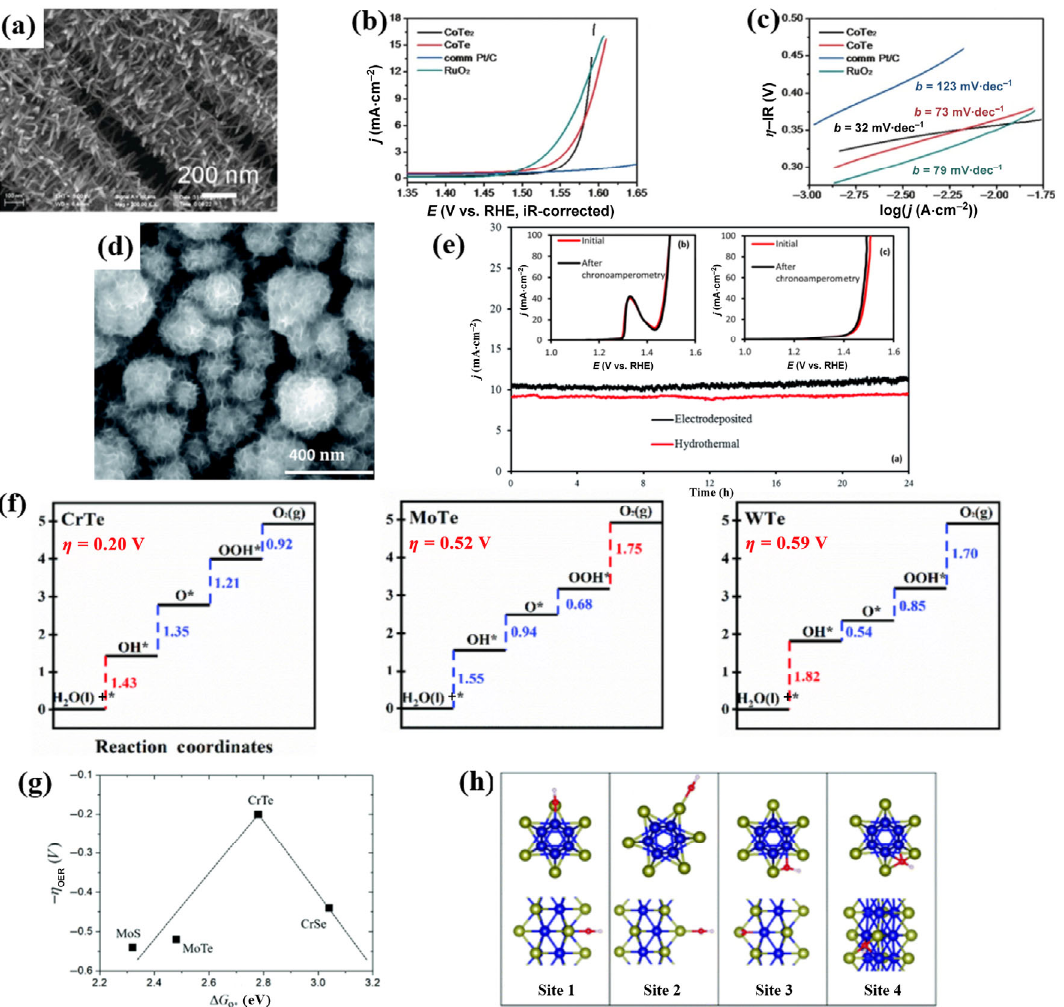
Figure 4 (a) Scanning electron microscopy (SEM) images of hierarchical CoTe 2 nanofleeces. (b) LSV curves of the CoTe 2 and CoTe. (c) Tafel slopes of the CoTe 2 and CoTe. (d) SEM images of Ni 3 Te 2 composed of randomly oriented nanoflakes. (e) Stability study of the electrodeposited and hydrothermally synthesized Ni 3 Te 2 through chronoamperometry at a constant potential of 1.44 and 1.45 V vs. RHE. (f) Electrochemical step diagram of CrTe, MoTe and WTe for OER process at zero potential. (g) The volcano plots of CrTe. (h) Possible adsorption sites for OH on double cell MX wires. Among them,